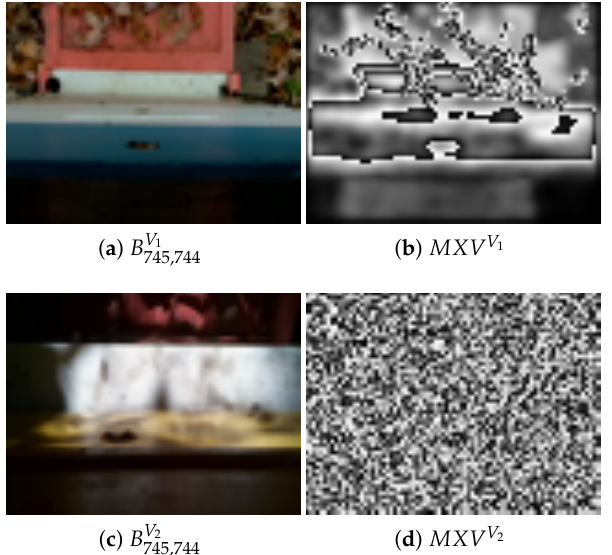
is the background frame of V 1 ; MXV V 1 745,744 is 745,744